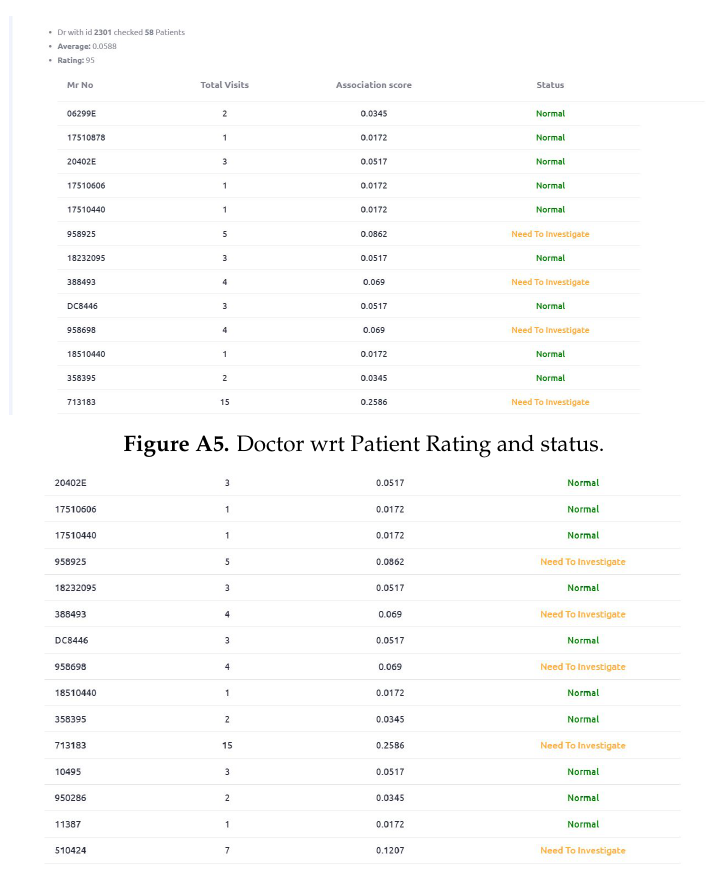
Figure A6. Doctor wrt Patient Rating and